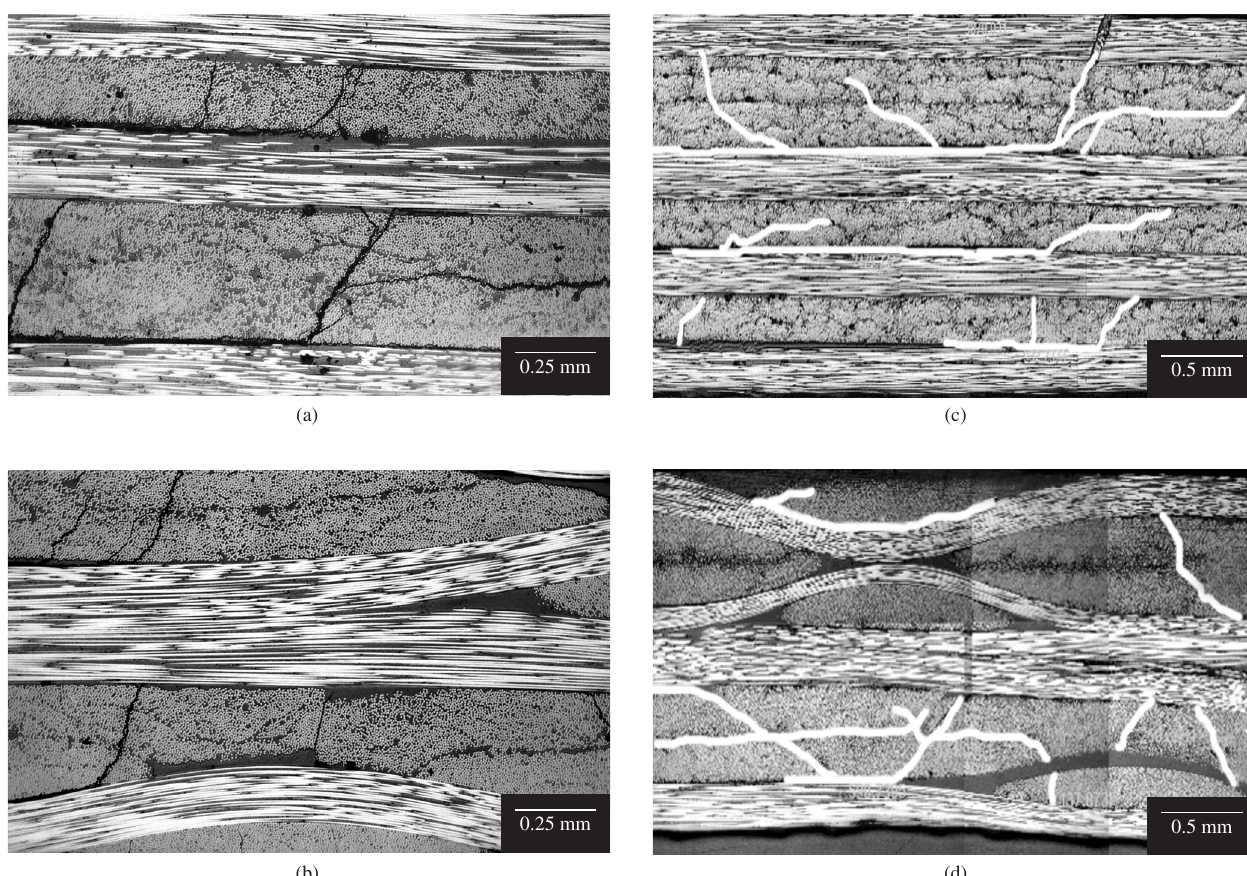
Figure 8. Micro-photographs of cross-sectional areas of carbon-epoxy composite laminates after fatigue loading: a,b) Local view of unidirectional cross-ply tape and two-dimensional woven fabric arrays, respectively; and c,d) General view (crack paths have been highlighted in order to improve damage